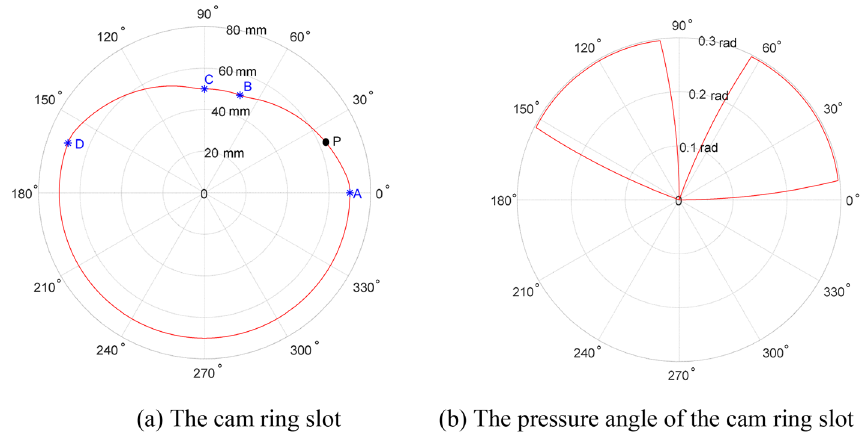
Figure 6. The calculated curve of the cam ring and its pressure angle. (Matlab2019a. https:// ww2. mathw orks. cn/ produ cts/ get- matlab. html?s_ tid= gn_